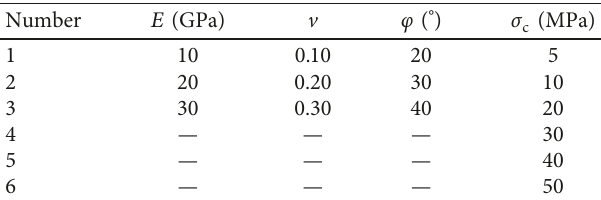
Table 1: Parameters used in the FEA